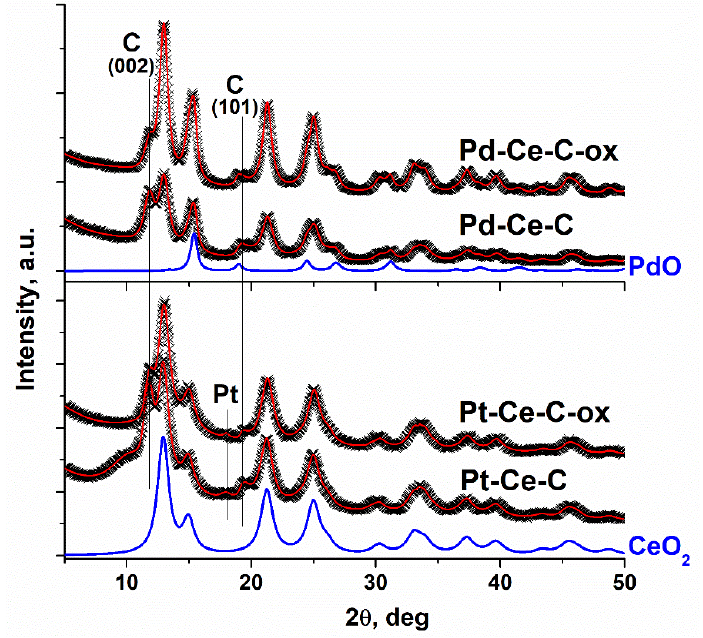
Figure 1. XRD data for the Pd-based and Pt-based samples. Experimental data ((x) lines), Rietveld. In order to calculate the structural parameters of the detected phases, a Rietveld refinement was performed. The scattering from the MWCNTs was modeled using a set of peaks, of which position, width, and relative intensity were taken from the profile refinement of the MWCNT sample. The obtained results are given in Table 1. The Pd-Ce-C and Pt-Ce-C catalysts are characterized by small CeO 2 particles of about 3 nm in size. The cell parameter ( a ) of CeO 2 ( a ~5.43 Å) is higher than the one typical for the bulk CeO 2 ( a (CeO 2 ) = 5.411 Å, ICDD PDF-2 #043-1002). The increased a (CeO 2 ) value and the microstrain parameter Δd/d ≈ 0.3 indicate the high defectiveness of the CeO 2 particles in the samples.